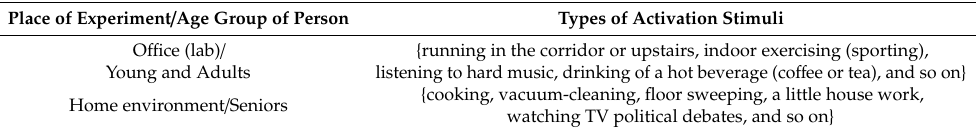
Table 1. Brief synopsis of the used types of activation stimuli depending on the experiment location and the age group of tested